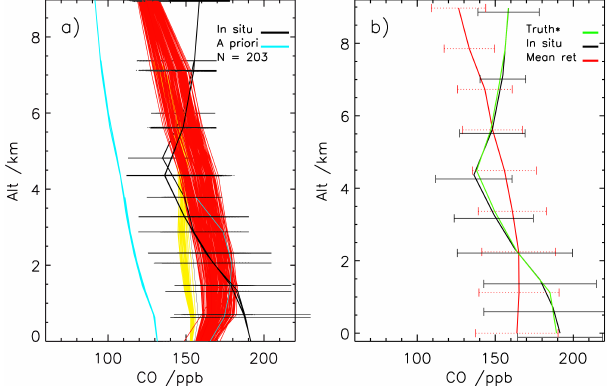
Figure 12. Carbon monoxide mean profiles as per Fig. 11 but for (a) flight B720 and (b) flight